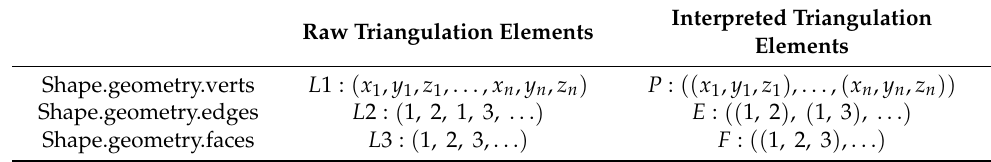
Table 2. Interpretation of raw triangulation elements. Raw Triangulation Elements